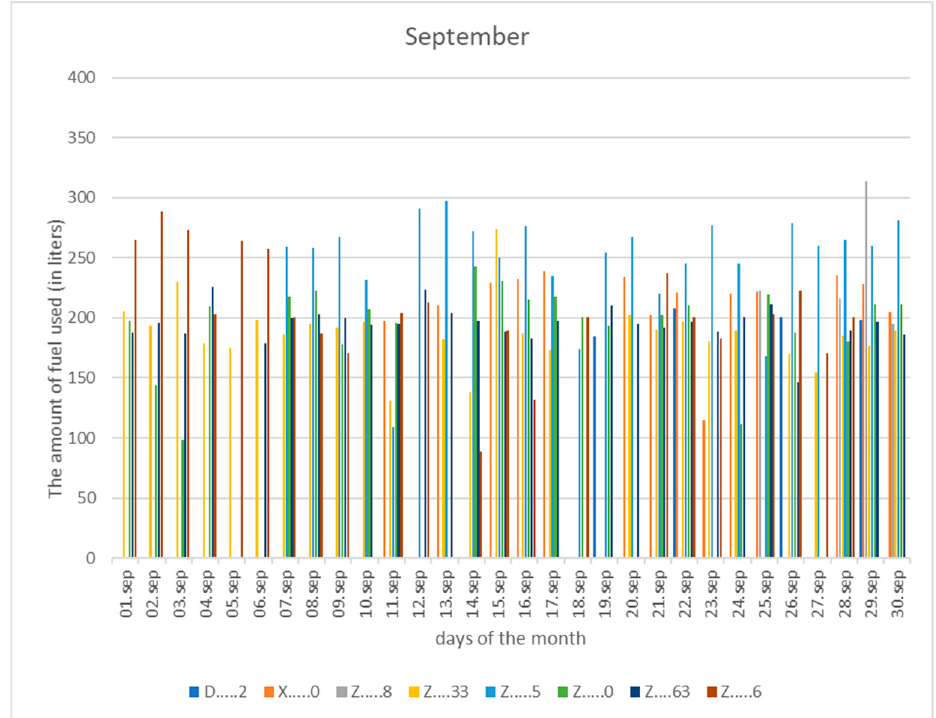
Figure 2. The amount of fuel used (in litres) for each vehicle in September.